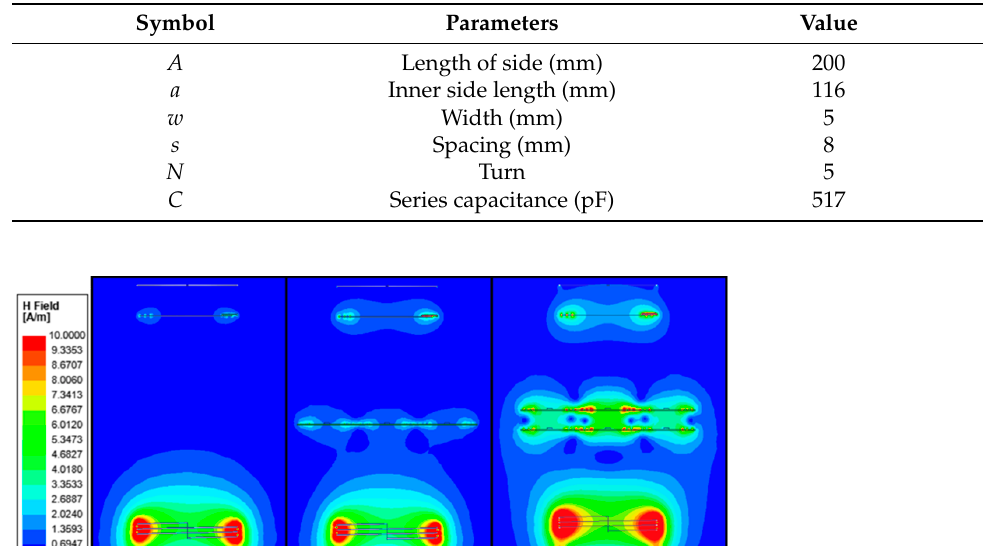
Figure 6. Comparison diagram of magnetic field intensity distribution for a system with one met- amaterial slab, a system with two metamaterial slabs, and a system without metamaterial slabs.